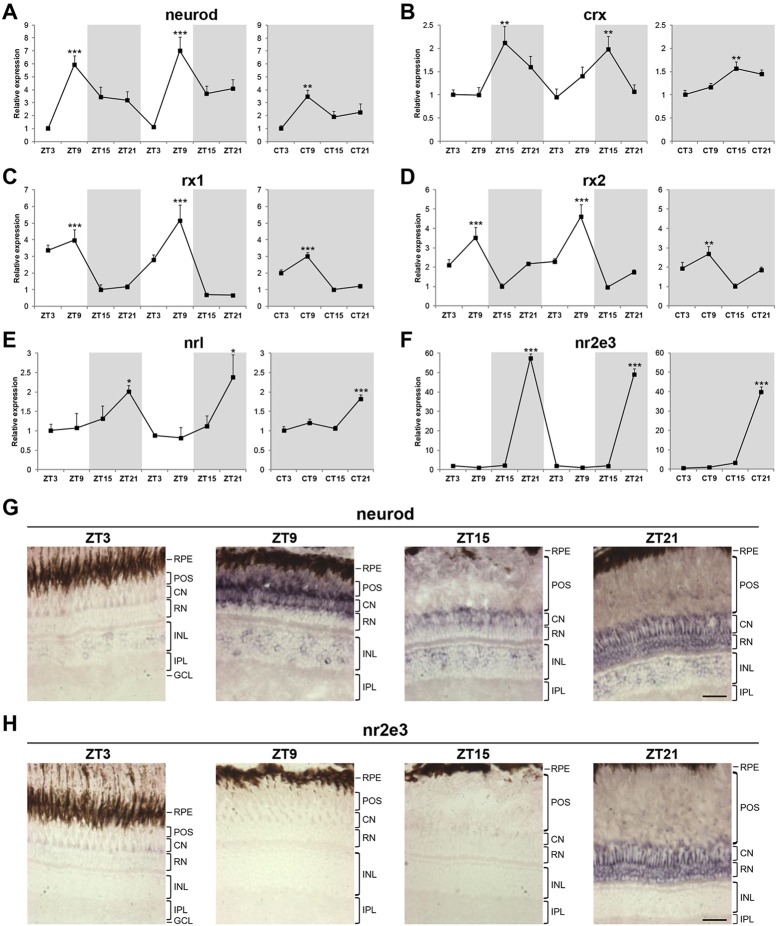
Circadian expression of retinal transcription factors is maintained in adult zebrafish. (A-F) qPCR analysis of neurod (A), crx (B), rx1 (C), rx2 (D), nrl (E) and nr2e3 (F) expression in adult eyes over two days of an LD cycle and one subsequent day of DD (n=3-4). Zeitgeber time (ZT) or circadian time (CT) indicates the four time points analysed per day. White and grey backgrounds represent light and dark phases, respectively. Statistically significant differences between the expression peak and trough on each day (Fisher's LSD test) are indicated: *P<0.05, **P<0.01, ***P<0.001. Error bars indicate s.e.m. (G,H) Representative images of in situ hybridisation for neurod (G) and nr2e3 (H) on adult eye sections at four time points. Note that expression in the photoreceptors at ZT21 is restricted to rods for both neurod and nr2e3. The signal present in the layer of cone nuclei corresponds to rod inner segments that connect the rod nuclei to the rod outer segments. RPE, retinal pigment epithelium; POS, photoreceptor outer segments; CN, cone nuclei; RN, rod nuclei; INL, inner nuclear layer; IPL, inner plexiform layer; GCL, ganglion cell layer. Scale bars: 30 µm.